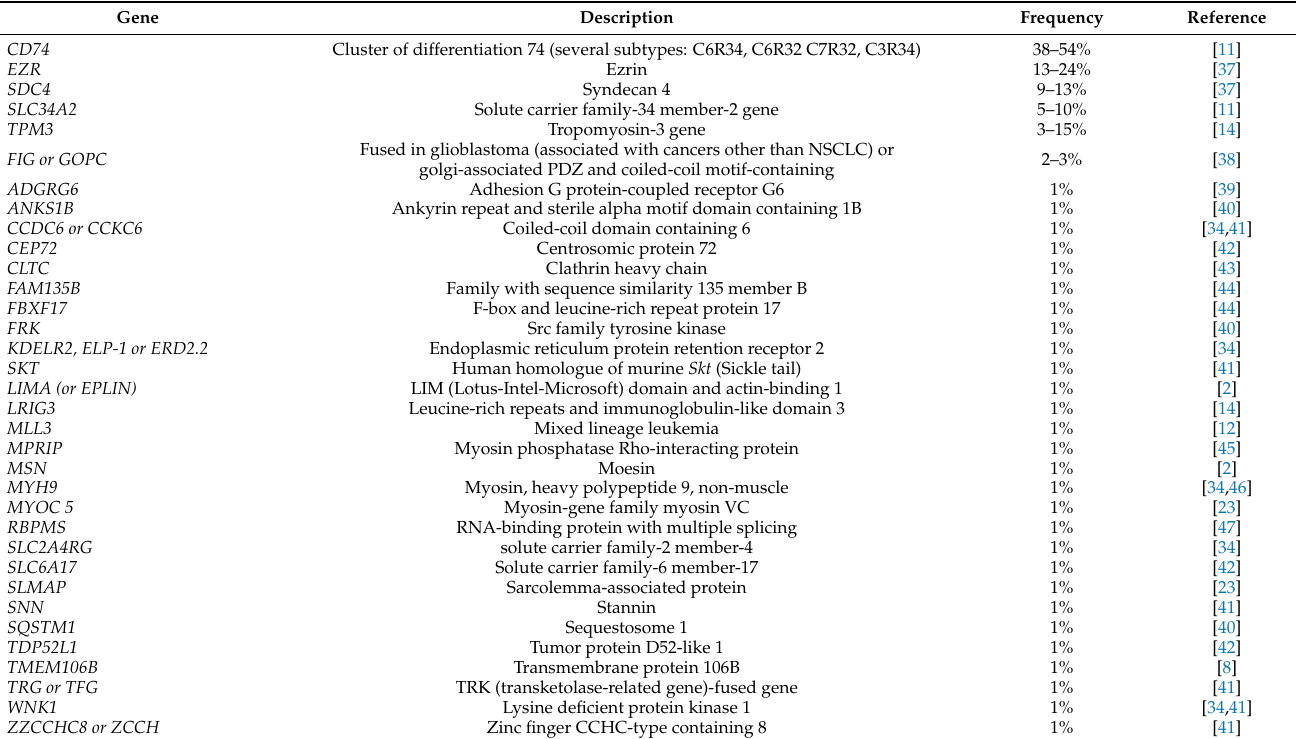
Table 1. Main ROS-1 -fusion partners in ROS-1 -positive non-small-cell lung cancers. Gene Description Cluster of differentiation 74 (several subtypes: C6R34, C6R32 C7R32, C3R34)